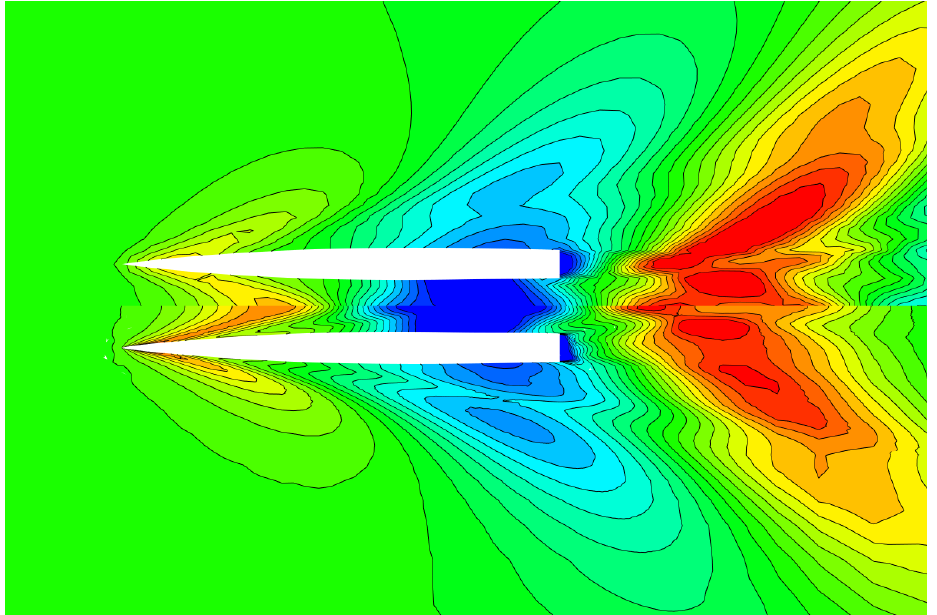
Figure 19. Free surface elevation computed for the baseline computed by SHIPFLOW (upper half of the cat’s wave pattern) and Neptuno (lower half of the cat’s wave pattern).